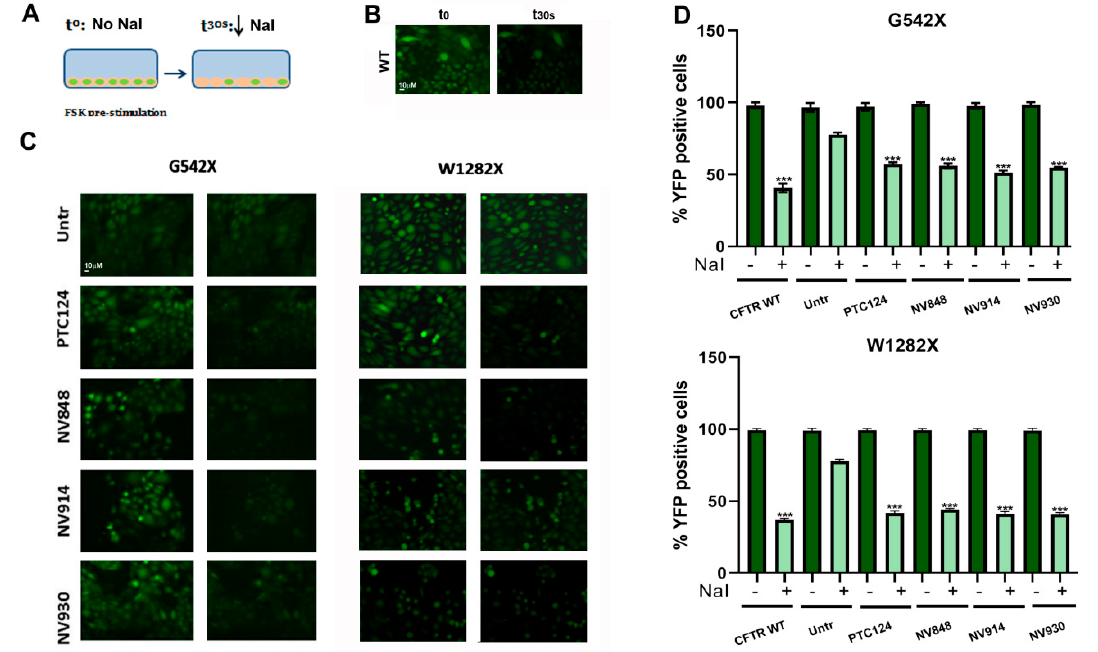
Figure 9. CFTR functionality in FRT cells measured by the yellow fluorescent protein (YFP) assay (pink: cells, green: YFP protein expression, blue: multiwell), ( A ) in YFP-CFTR WT FRT, and ( B ) CFTR G542X and CFTR W1282X FRT cells, untreated or treated with 12 µ M PTC124, NV848 , NV914 , or NV930 for 24 h ( C ). Cells were prestimulated with 20 µ M forskolin for 20 min. The experiment was performed in triplicate. Images were taken before (t 0 ) and after (t 30s ) the addition of NaI. Percentages of YFP-positive cells before ( − dark green bars) and after NaI addition ( + light green bars); data were analyzed by GraphPad ( n = 3) and expressed as mean values ± standard error of the mean (SEM) ( D ). Data were analyzed comparing treated FRT cells versus untreated FRT cells by GraphPad Prism 6 software ( n = 3). ***, p < 0.001 (ANOVA with Dunnett’s posthoc